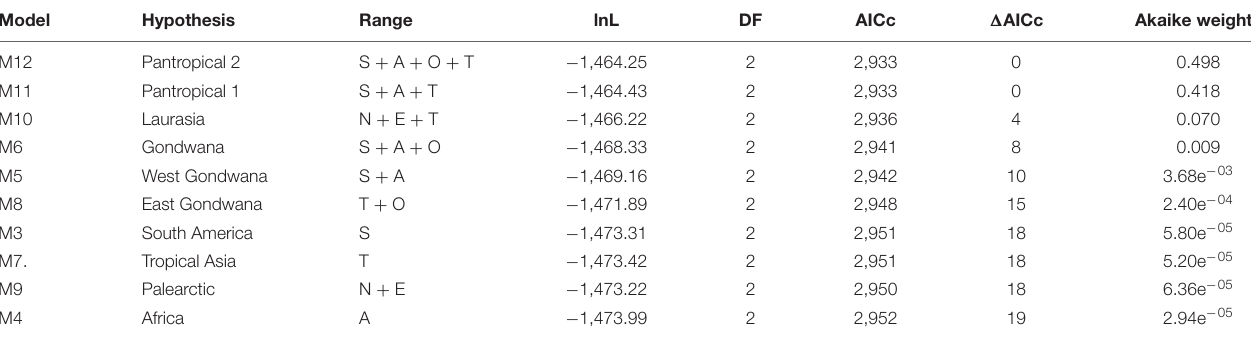
TABLE 1 | Results of biogeographic hypothesis tests on the origin of Apocynaceae detailing fit to the data of the ten constrained models (M3–M12) using the dispersal-extinction-cladogenesis model (DEC). Model